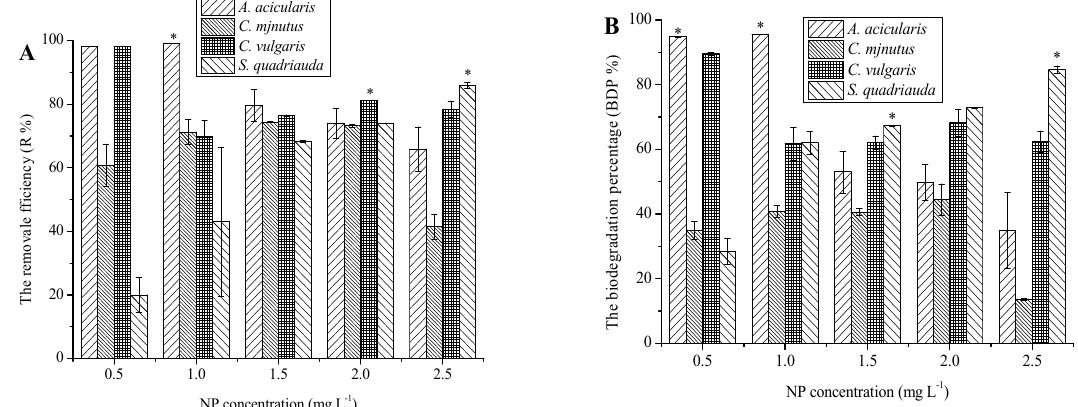
Figure 3. Removal ( A ) and biodegradation ( B ) of NP by A. acicularis , C. minutus , C. vulgaris and S. quadriauda at the end 120 h (mean and standard deviation of three replicates are shown. The single asterisk * in the figure represents significant difference compared to other algae species ( p < 0.05).